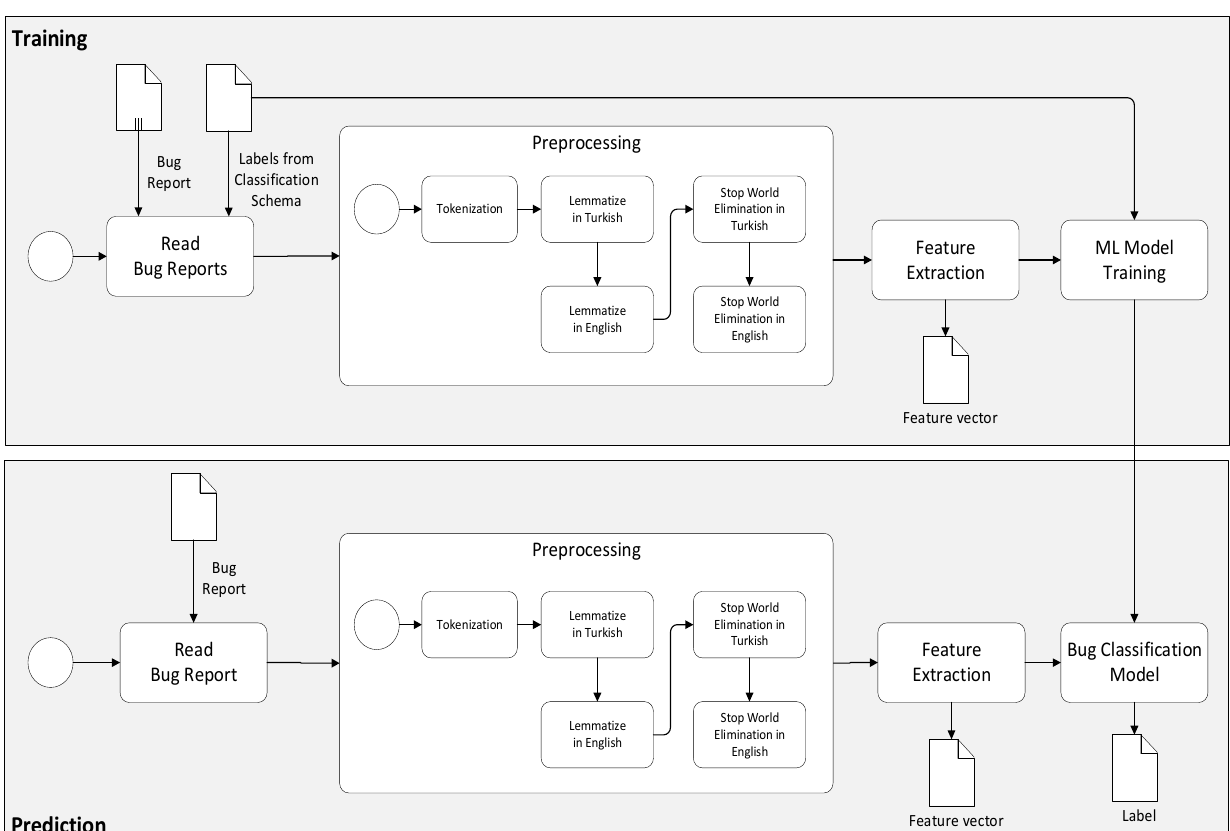
Figure 4. Proposed machine learning-based bug classification process for bilingual, unstructured bug reports.